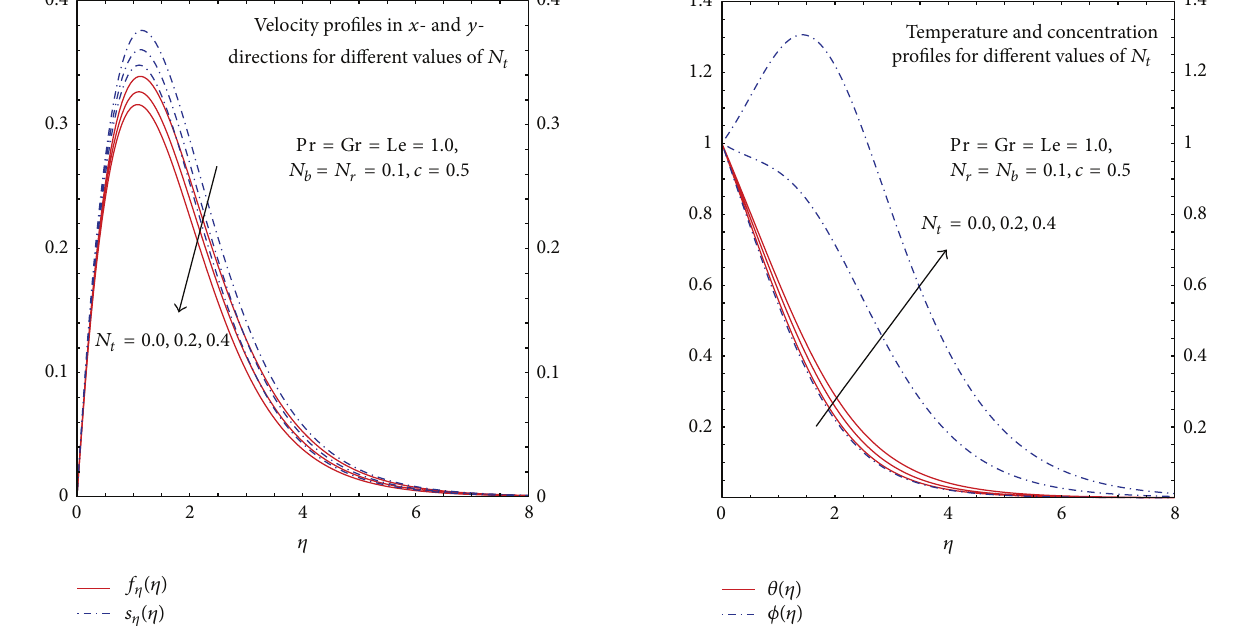
parameter plays a significant role in the flow, heat transfer, and mass transfer properties.